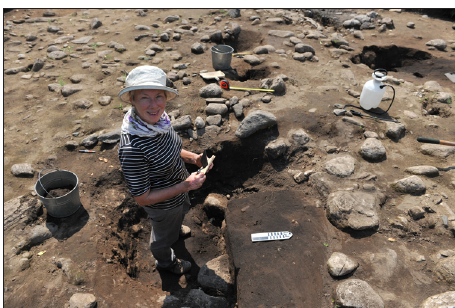
Figure 3: Sue Colledge documenting a mul- tiphase Late Archaic storage pit (Photo